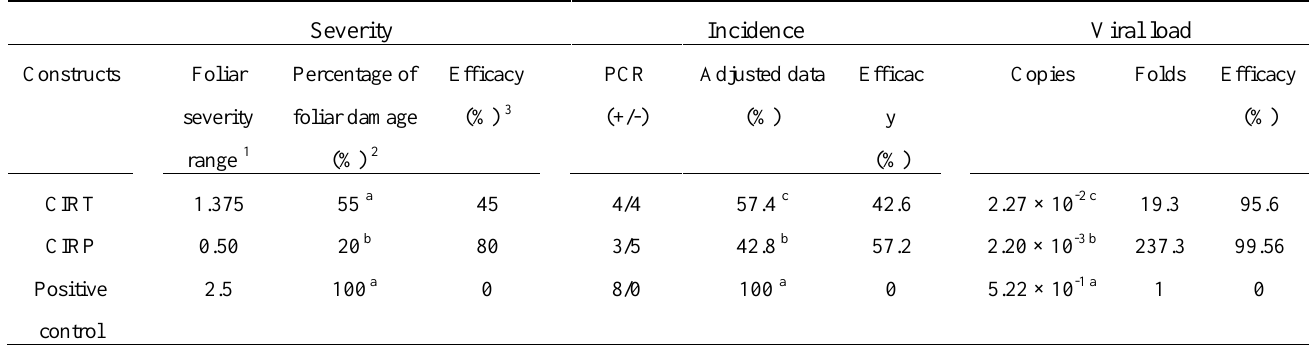
Table 1. Summary of findings on comparative effectiveness of two RNAi constructs to reduce symptoms, incidence and viral DNA accumulation in experimental PepGMV